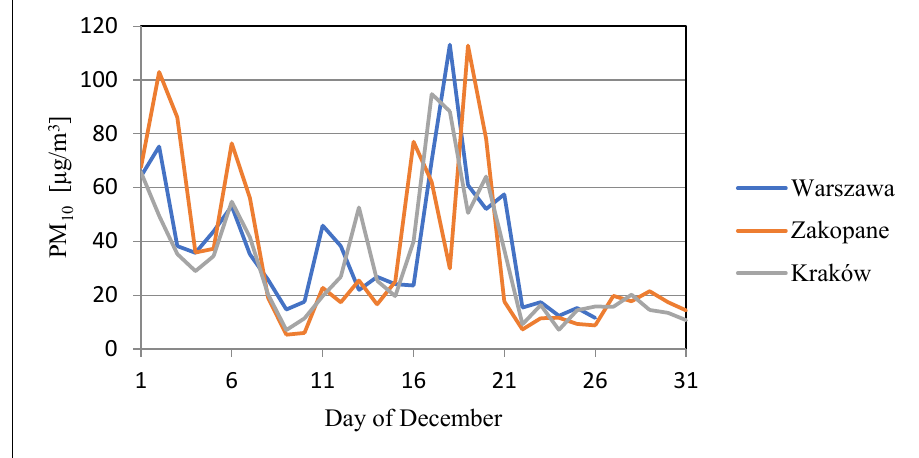
Figure 1. Daily average urban district PM 10 dust concentration in December 2018 [14].